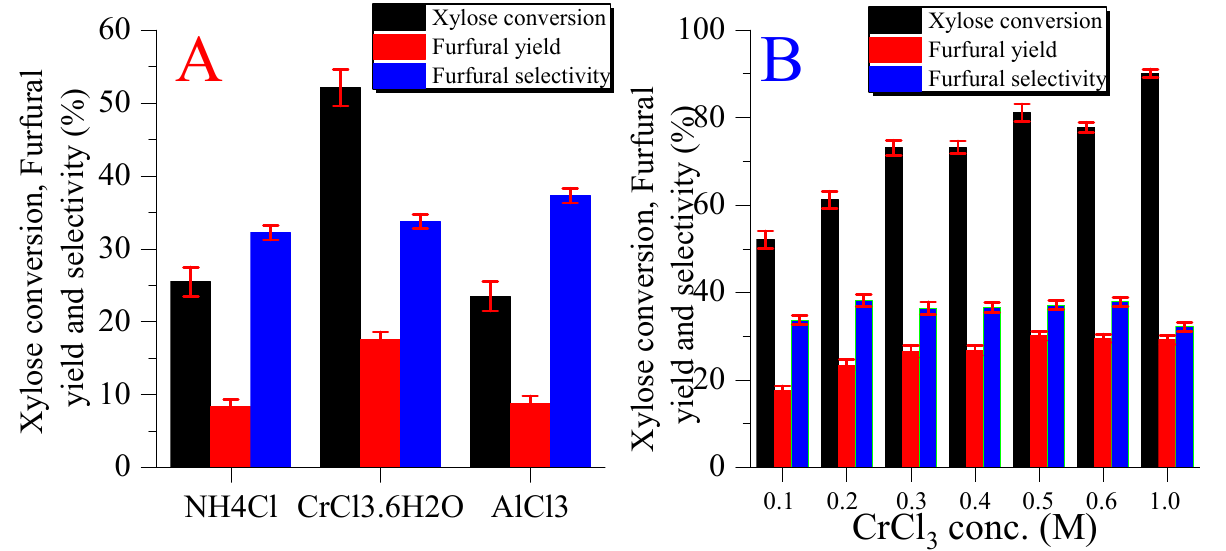
Figure 1. Xylose conversion into furfural. Reaction conditions: 0.5 M xylose and 1.0 M p TSA in 50 mL H 2 O with reaction temperature 100 °C and constant stirring at 200 RPM. ( A ) 0.1 M of different Lewis acids, ( B ) different concentrations of CrCl 3 .6H 2 O.